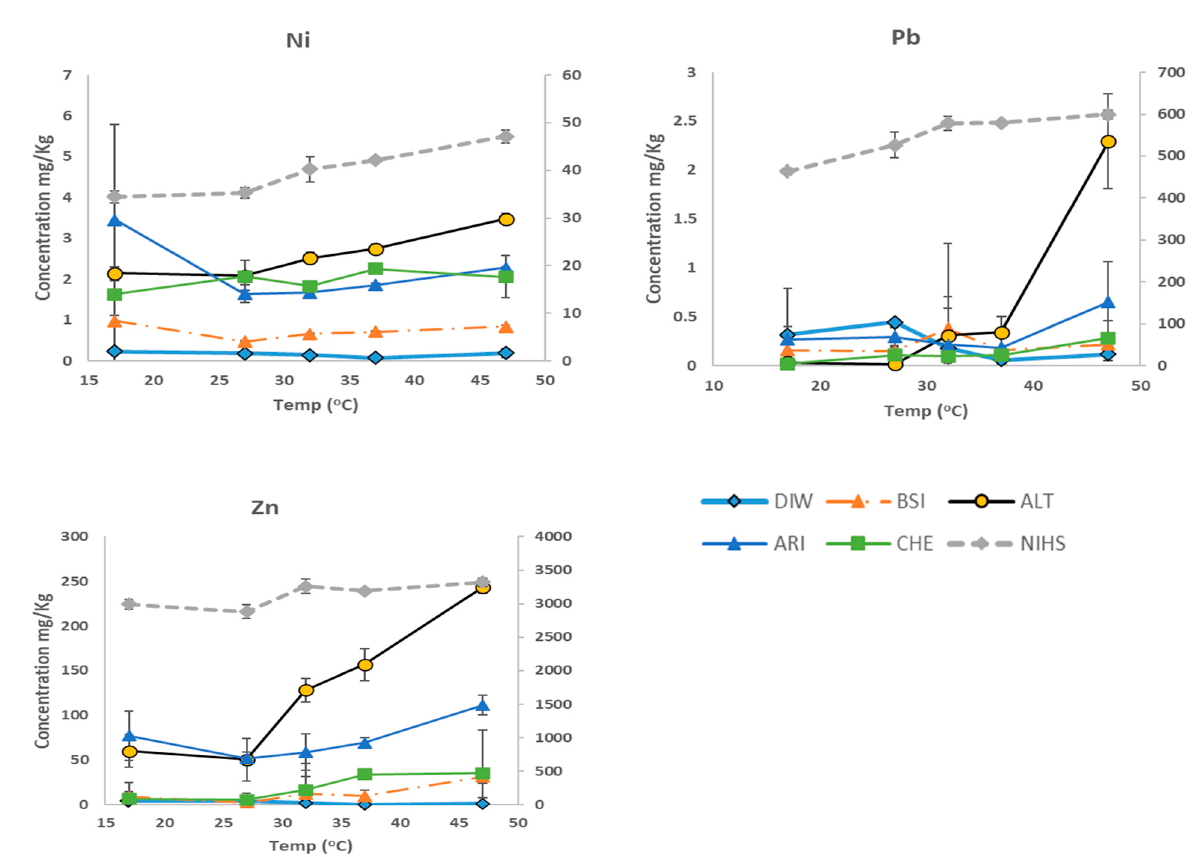
Figure 3. Dermal bioaccessible concentrations of Ni, Pb and Zn in bulk composite soil sample using different artificial sweat solutions and extraction temperatures. Results are plotted against the primary ( left-hand ) axis except NIHS, which is plotted against the secondary ( right-hand ) axis.